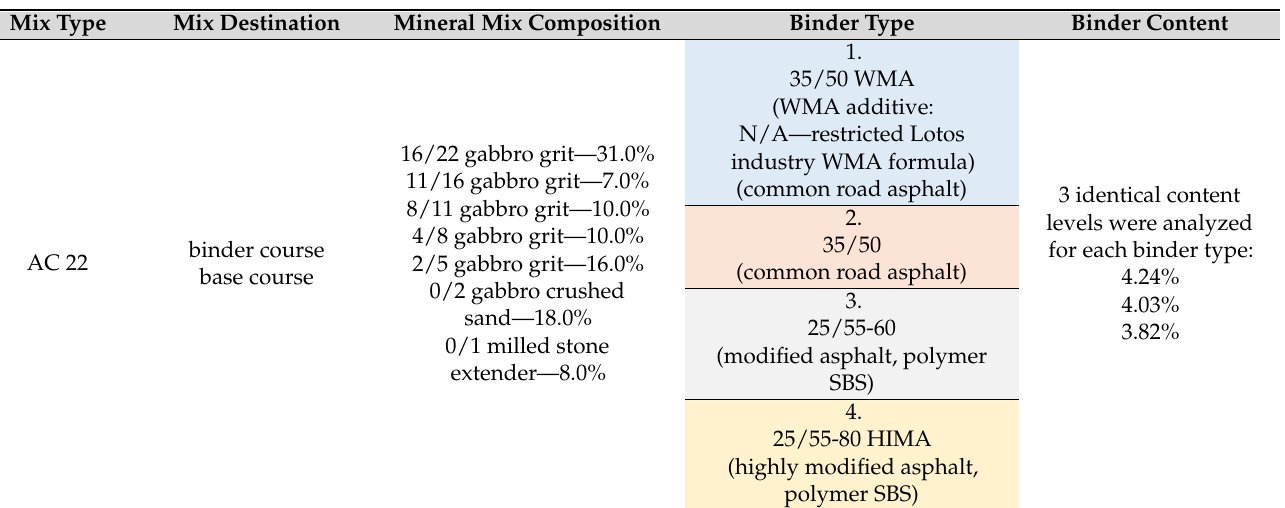
Table 1. Mineral asphalt mixtures